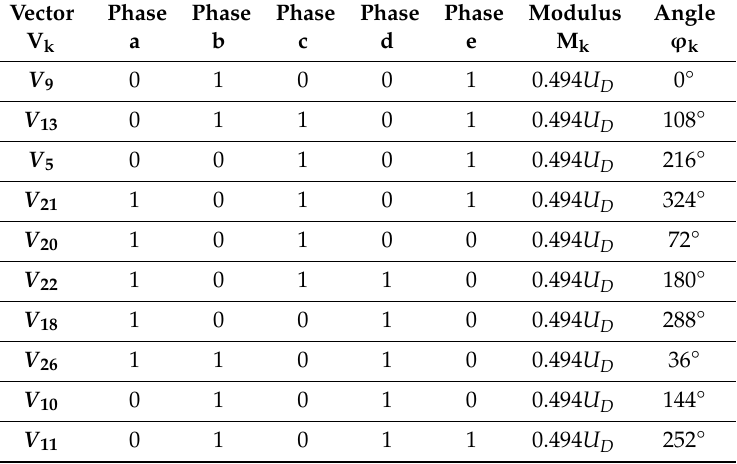
Figure 11. Polar ( a ) and phase-to-phase ( b ) voltage waveforms: the pentagon connected load. Vector sequence: V 9 , V 13 , V 5 , V 21 , V 20 , V 22 , V 18 , V 26 , V 10 , V 11 . Table 3. Collected parameters of the vectors. Red color denotes potential + U D , green color – potential